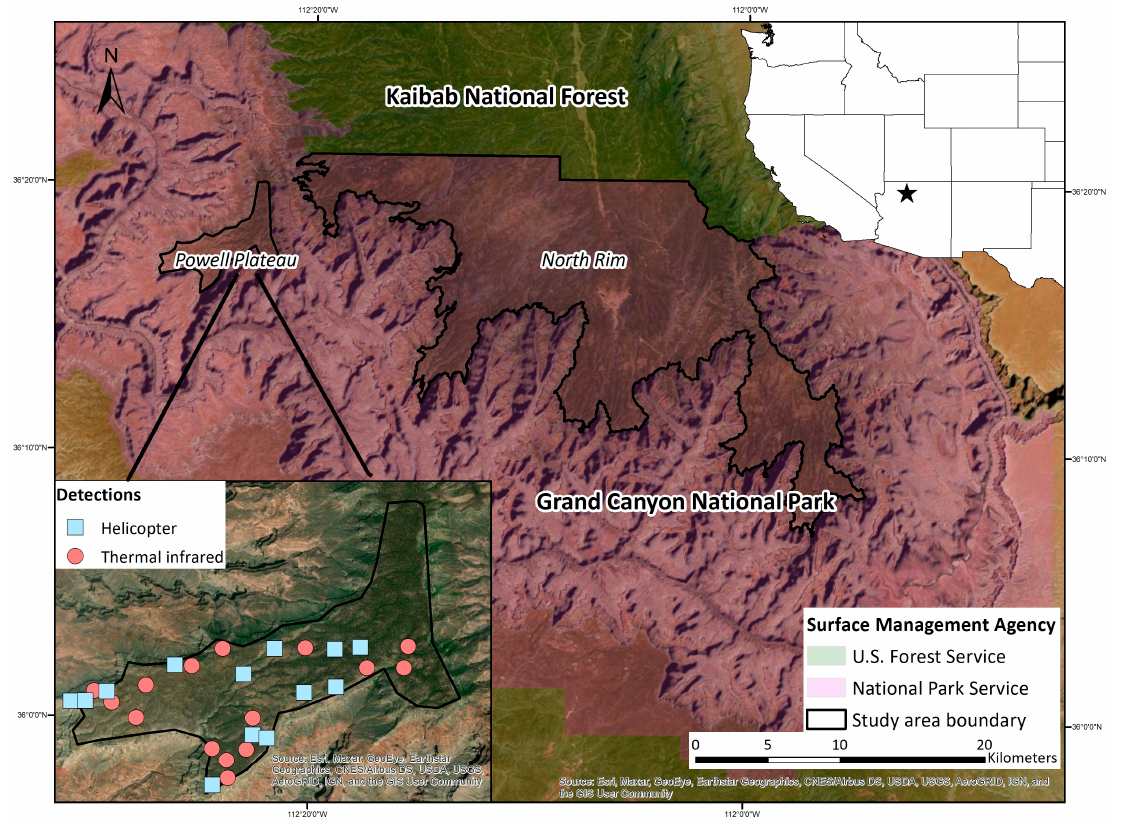
Figure 1. Location of study area and surface management agencies, Powell Plateau, and North Rim of Grand Canyon National Park, USA. Inset displays the location of bison group detections made by helicopter and thermal infrared surveys on Powell Plateau, 11 February